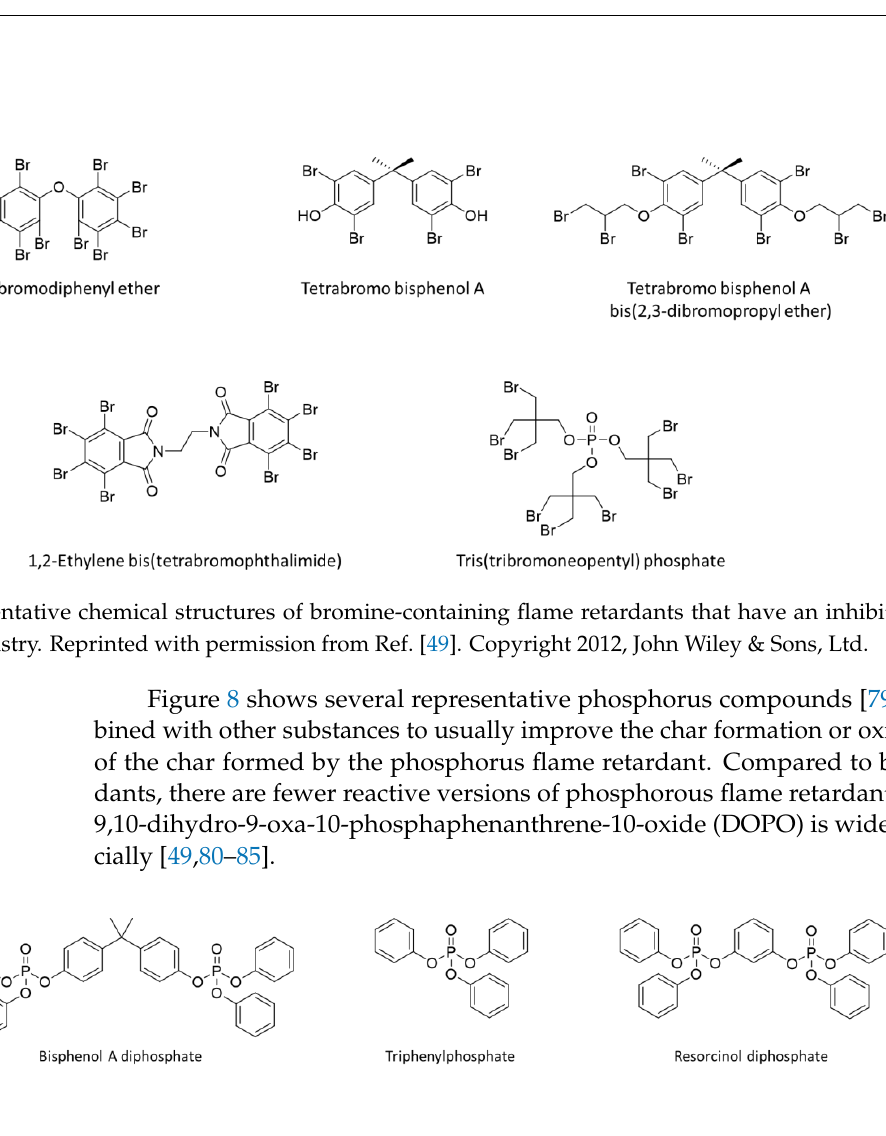
7 of 49 Table 2. Classification of flame retardants [72,73]. Classification by usage